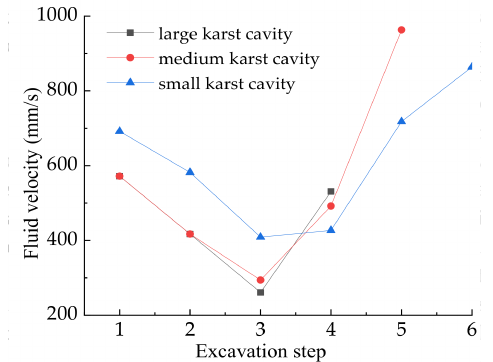
Figure 14. The change of fluid velocity during tunnel excavation.